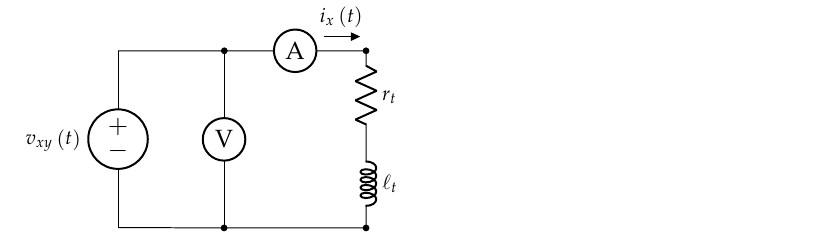
plied voltages were limited by the rated current of the motor and the power source used.